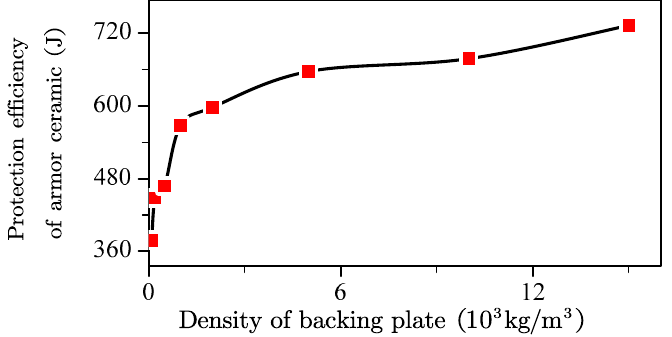
Figure 7. Change in the law of energy absorption and density of the ceramic layer under the 2-mm back plate.